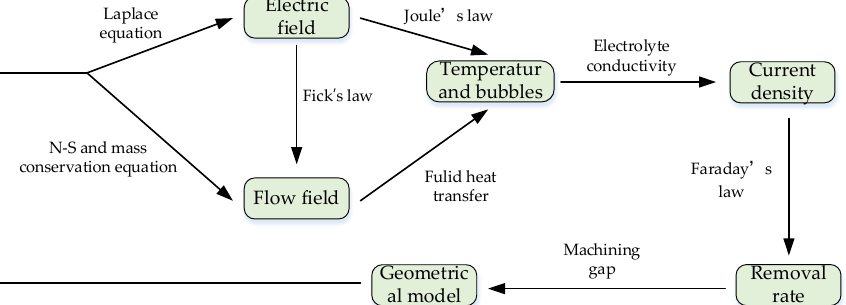
Figure 1. Schematic diagram of multi-physics coupling relationship.